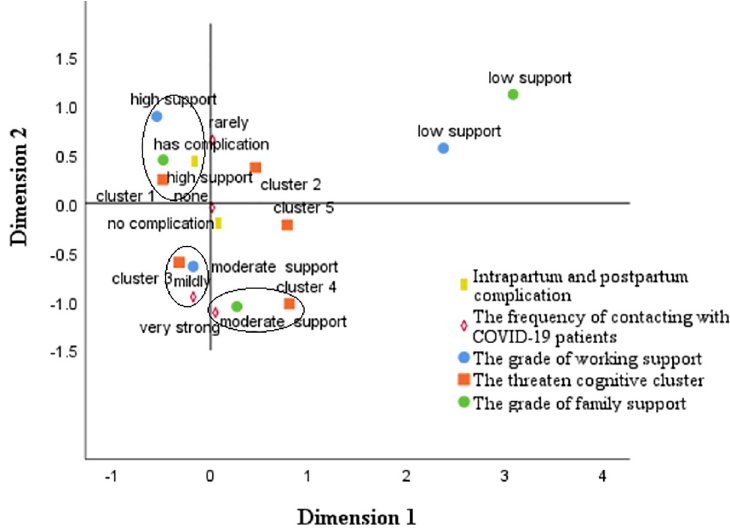
Fig 4. Joint category plots: The threatened cognitive types in relation to background factors. https://doi.org/10.1371/journal.pone.0239697.g004 statistical difference: the index of somatization symptoms in clusters 1 and 2 were significantly lower than in the three other clusters. The index of neurasthenia in clusters 1 and 2 was nota- bly lower than clusters 4 and 5. The degree of depression, anxiety and force at the same time in